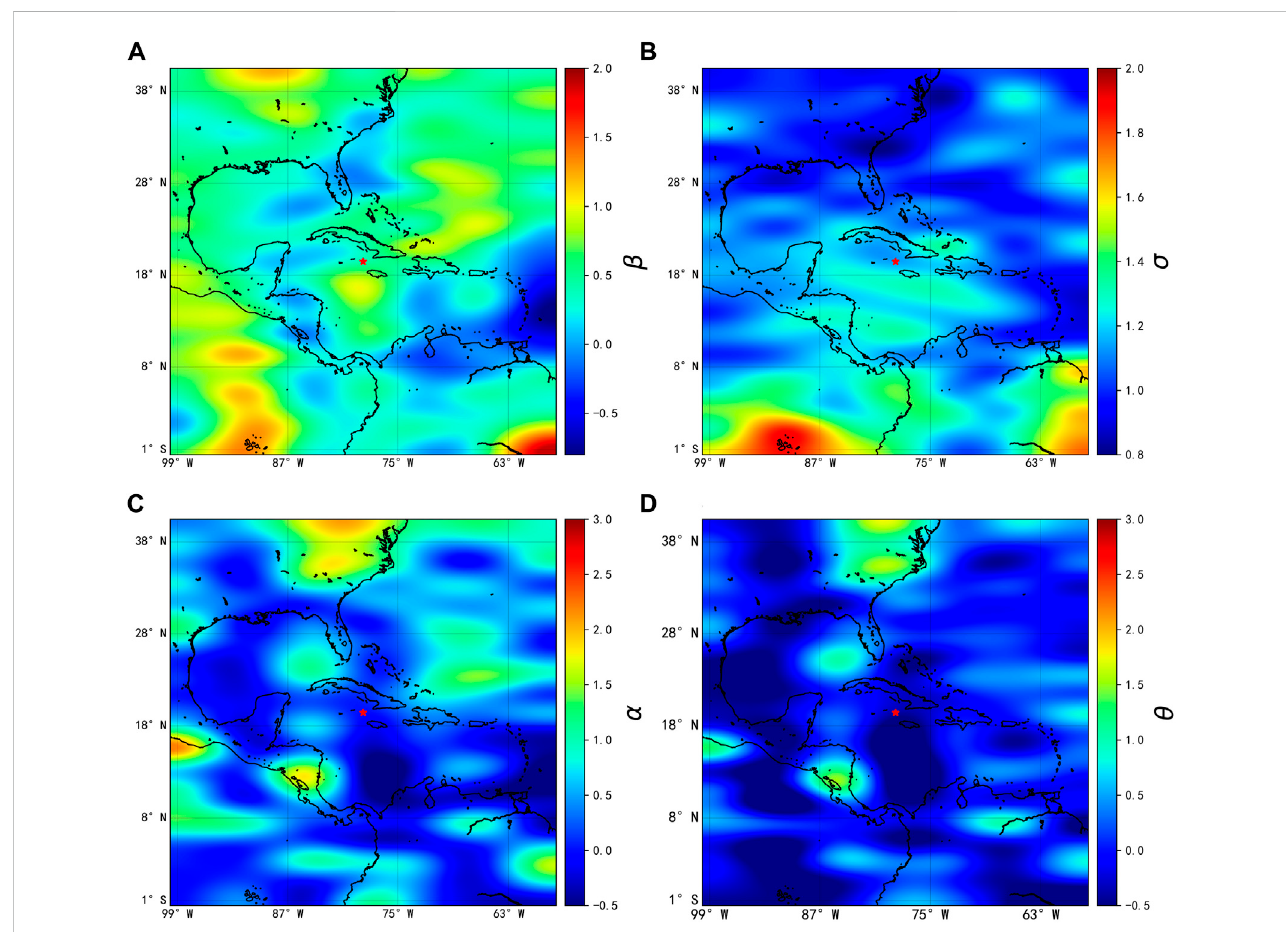
FIGURE 1 ConstructionprocessoftheC-valueperturbationamplitudematrix θ within±20 ° oftheepicenter oftheMw7.7earthquakeoffsouthernCuba. (A) Matrix of background fi eld averages constructed from C values from 70 to 40 days before the earthquake β ; (B) Matrix of standard variance values σ of the background fi eld constructed from the C-values from 70 to 40 days before the earthquake; (C) The mean matrix α constructed from the C-values from 45 to 35 days before the earthquake; (D) The resulting matrix θ calculated according to Eq.